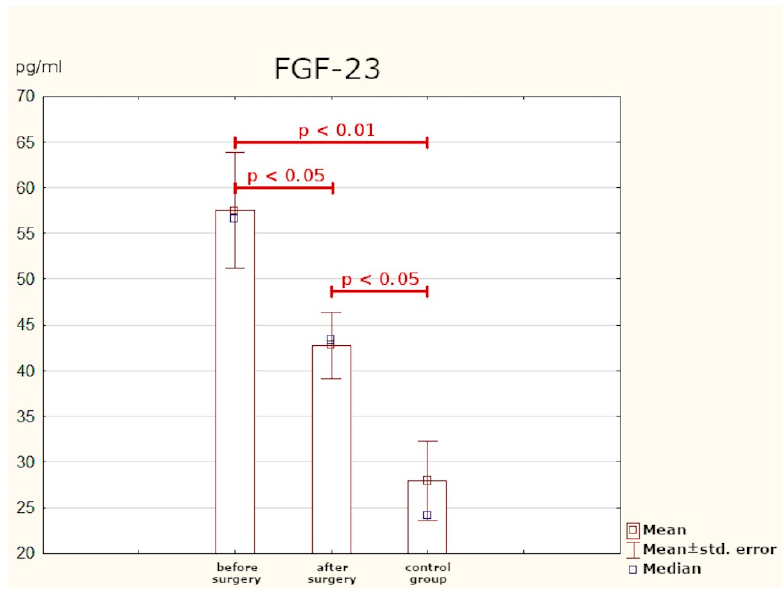
Figure 1. Plasma concentrations of FGF-23.